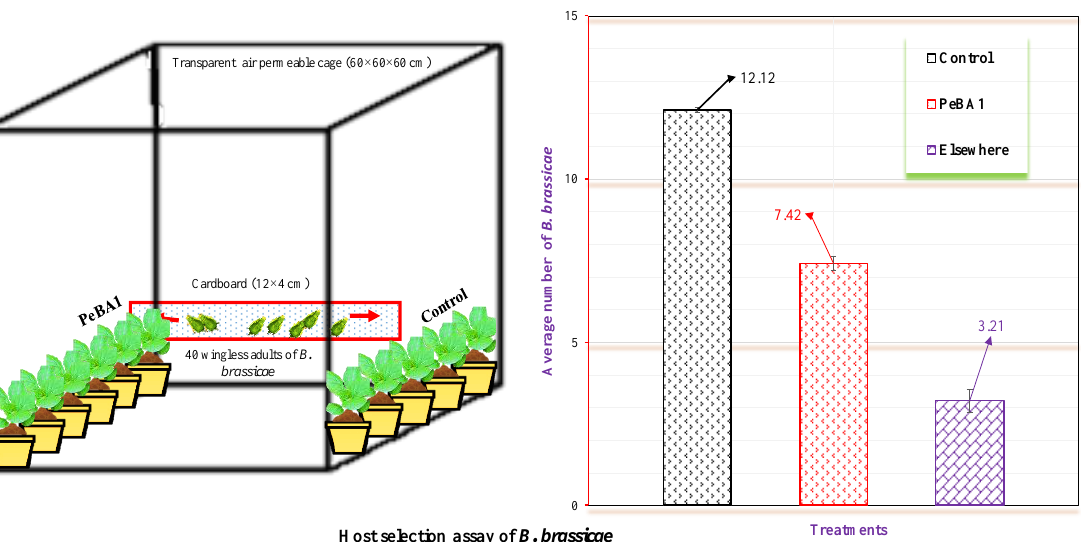
Figure 2. Brevicoryne brassicae colonization on seedlings treated with PeBA1-treated and control (mean ± SD). The study used a (CRD) randomized statistical design. Data were compared using one-way ANOVA and the least significant difference (LSD) ( p = 0.05) with SPSS 18.0.